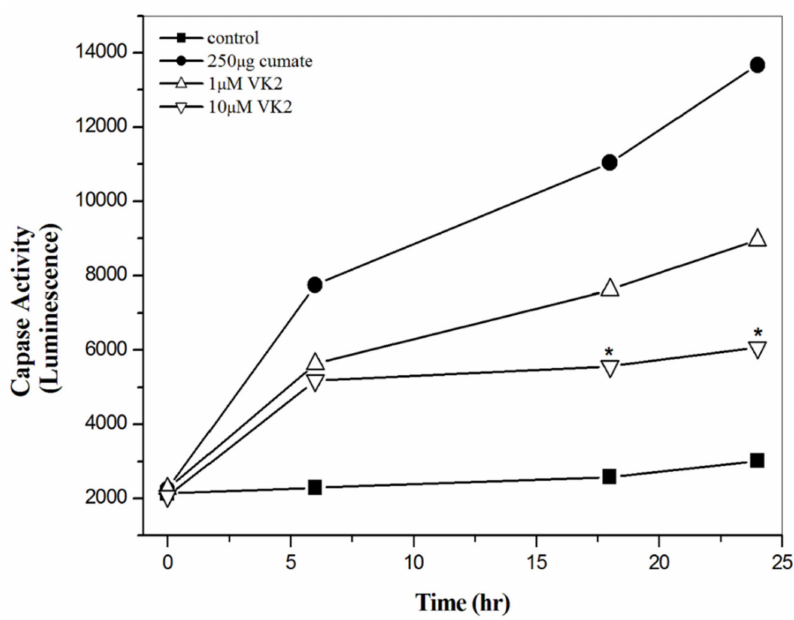
Figure 3. Inhibition of caspase-3 activity by vitamin K2. β -CTF/C6 cells were treated with 250 µ g cumate and 0 and 10 µ M of vitamin K2 (VK2). Caspase-3 activity was measured at 0, 6, 16 and 24 h. * p < 0.05 compared to the 250 µ g